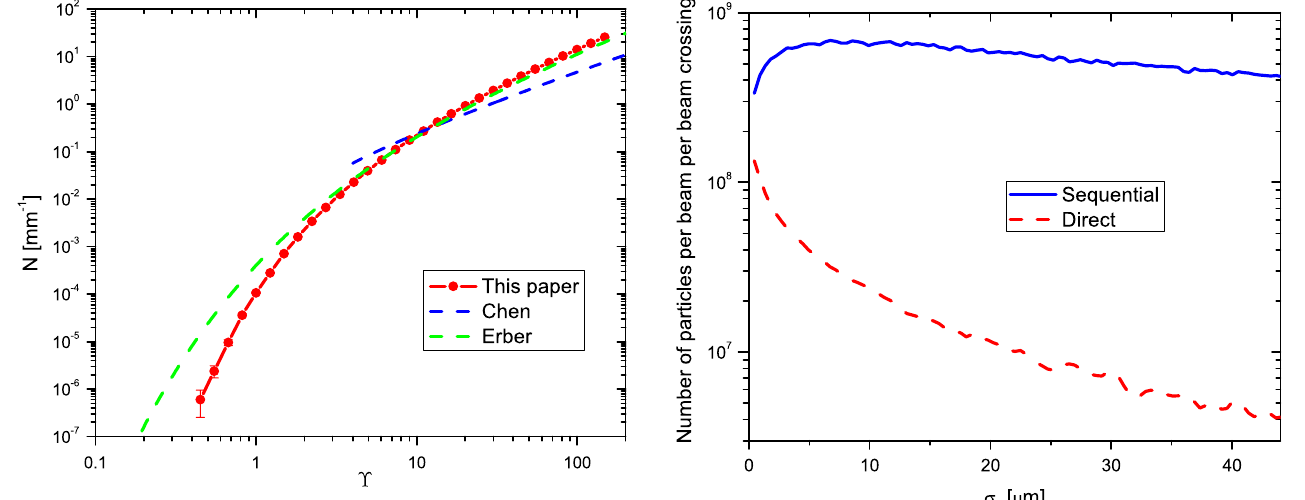
FIG. 8. Total yield of direct tridents at a primary energy of 250 GeV. Red: Monte Carlo simulation, this paper. Blue dashed: approximate expression by Chen [15]. Green dotted: Erber [14]. Note that the Chen and Erber curves are shown outside of their respective regions of validity.